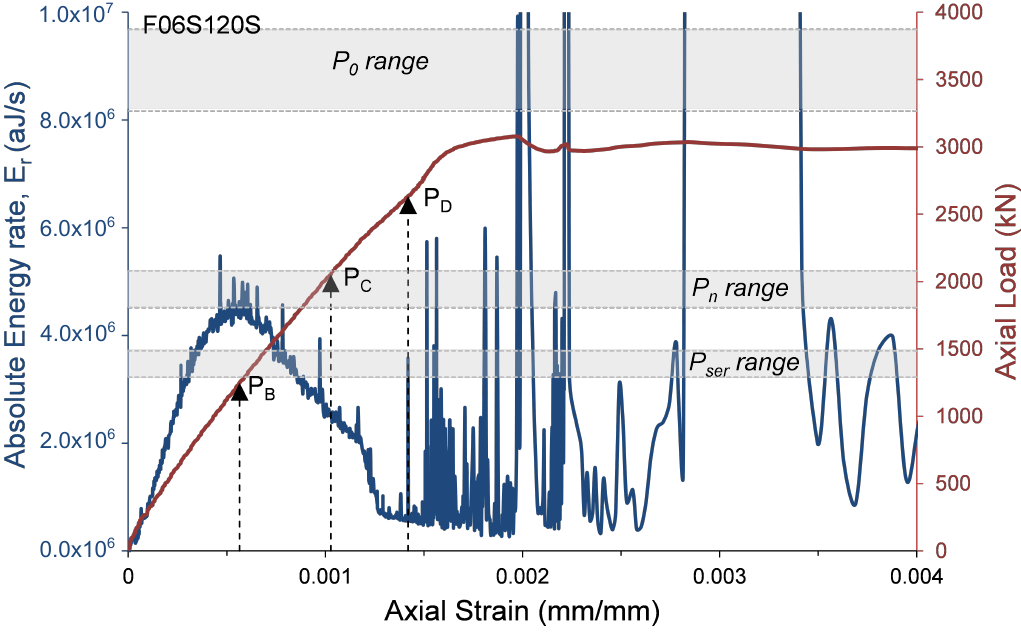
Figure 9. Absolute energy and axial load versus axial strain—specimen F06S120S.